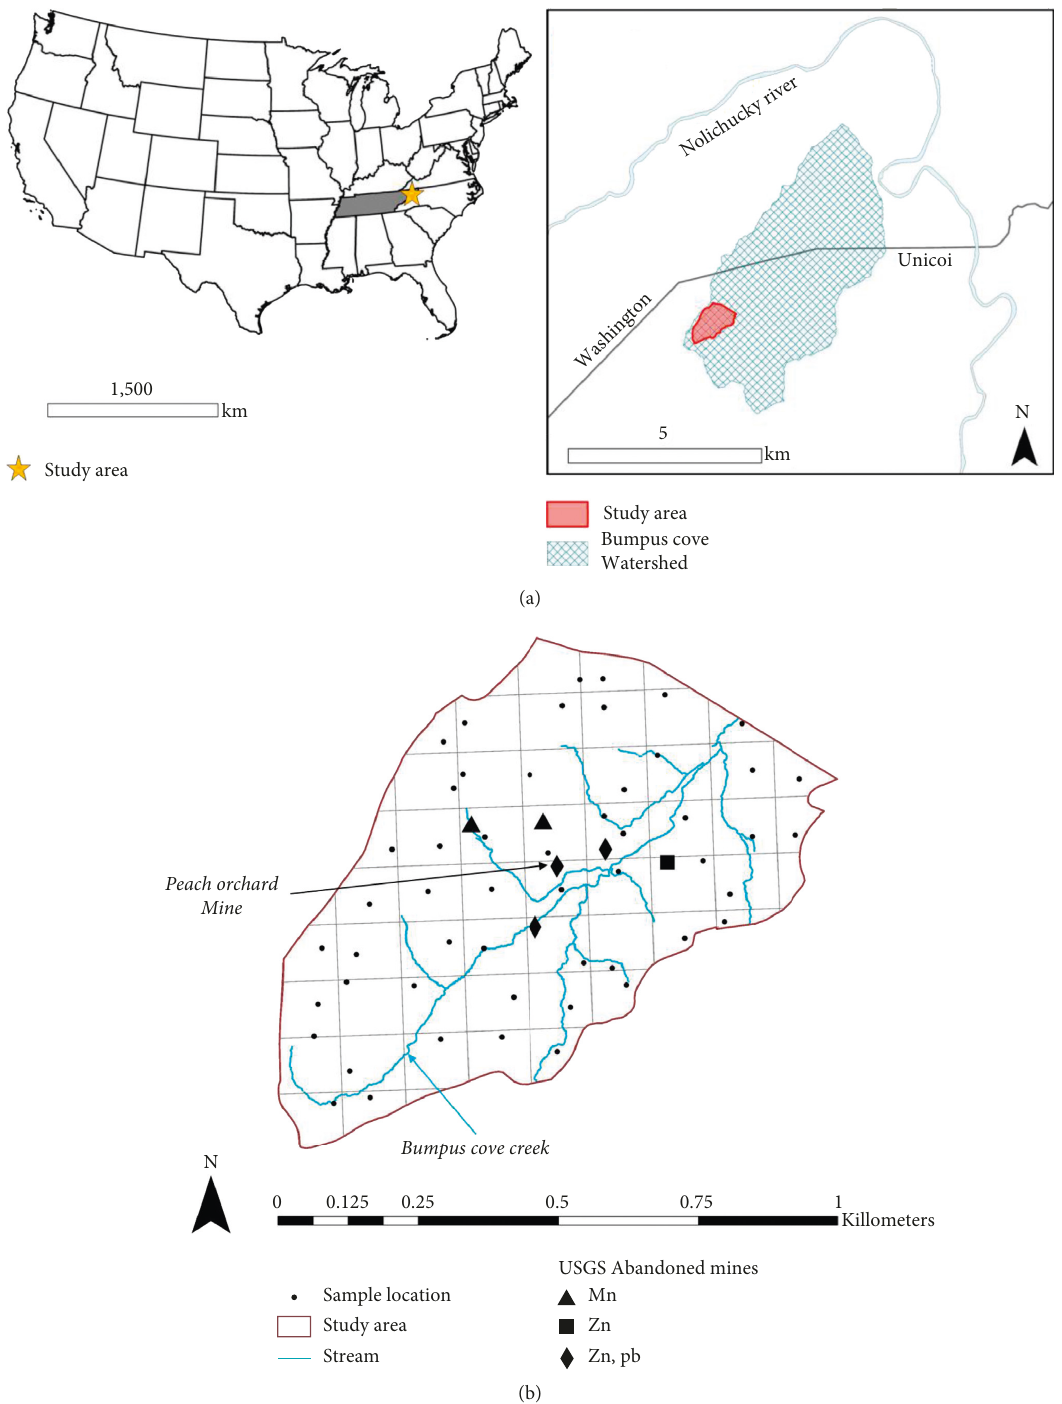
Figure 1: (a) Location of the study area (0.67km 2 ) in the southwest corner of the Bumpus Cove watershed ( ∼ 19.5km 2 ), Washington and Unicoi counties, Tennessee, and (b) study area sample and mine locations relative to Bumpus Cove